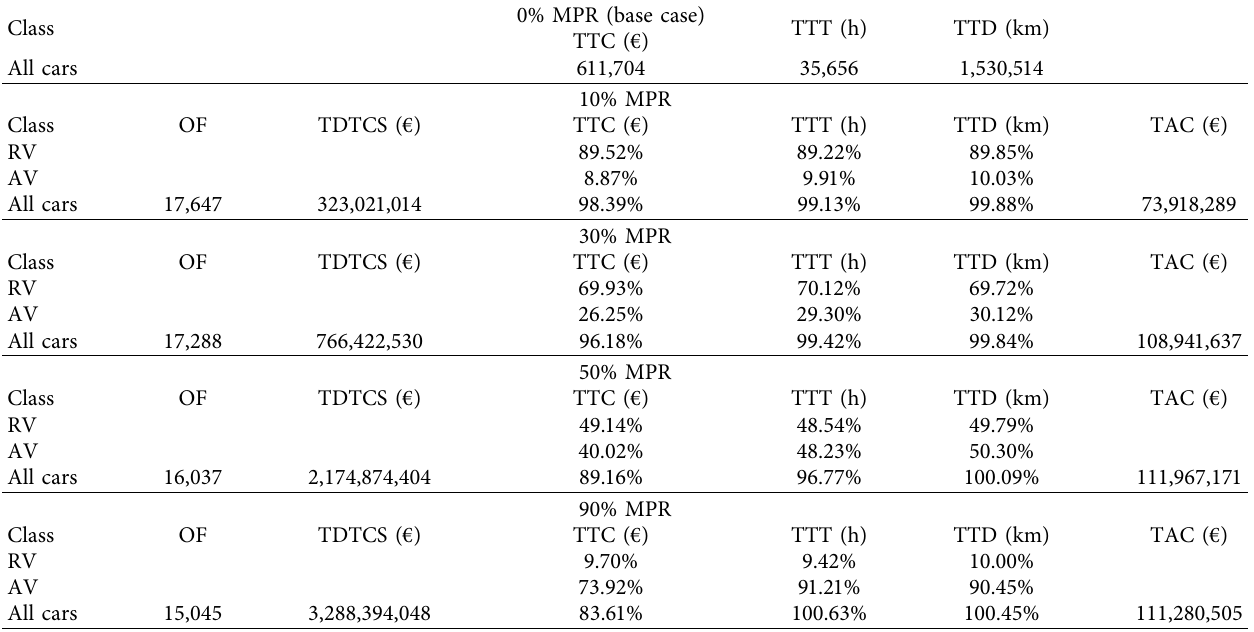
Table 3: Key performance indicators for network of Amsterdam (indexing is based on the base